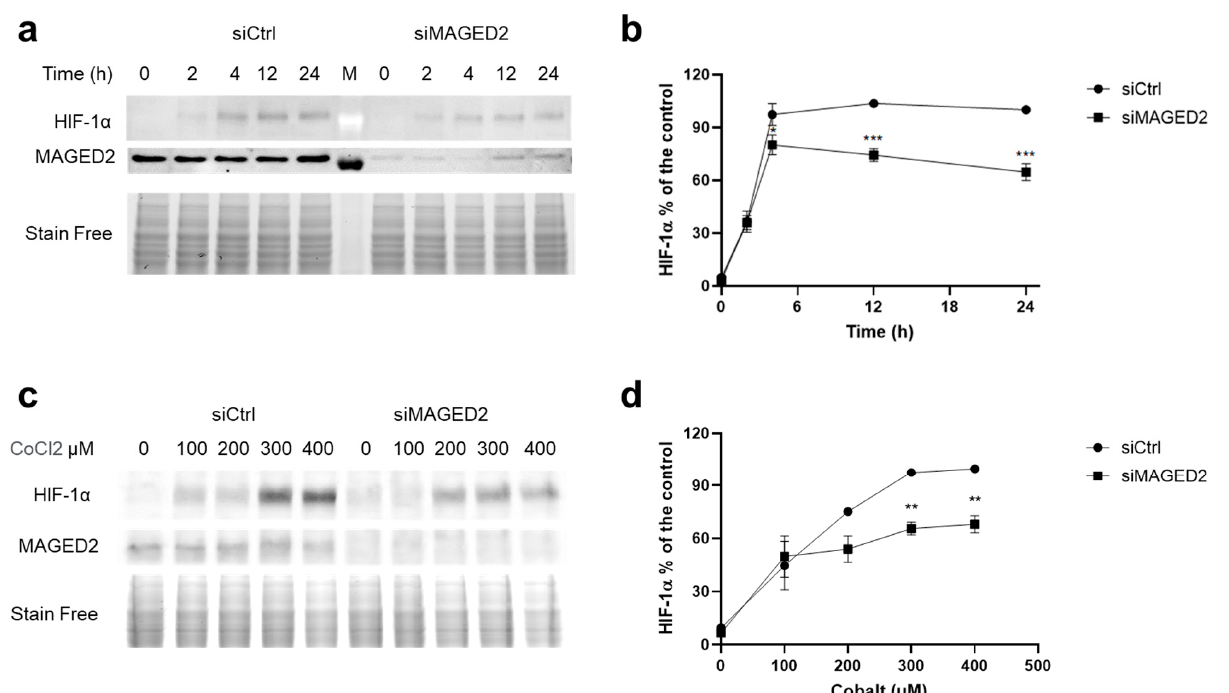
Figure 2. MAGED2 promotes hypoxic HIF-1 α protein expression in HEK293 cells. HEK293 cells were transfected with control (siCtrl), and MAGED2 (siMAGED2). Briefly, 24–48 h post-transfection, cells were exposed to physical hypoxia ( a ) or to the hypoxia mimetic CoCl 2 ( c ): ( a ) Cells were exposed to physical hypoxia (1% O 2 , 5% CO 2 , 94% N 2 ) for the specified times. ( c ) Cells were exposed to CoCl 2 with the indicated dose for 14–16 h. Total cell lysates were separated by SDS-PAGE and probed with anti-HIF-1 α and MAGED2 antibodies. ( b , d ) Densitometric analysis of HIF-1 α immunoblot is presented in ( a , c ), respectively. Statistical significance was determined by two-way ANOVA test. All Western blots shown are from the same experiment, which is a representative example of three independent experiments. Bar graphs show mean ± SEM. * p ≤ 0.05, ** p ≤ 0.01 and *** p ≤